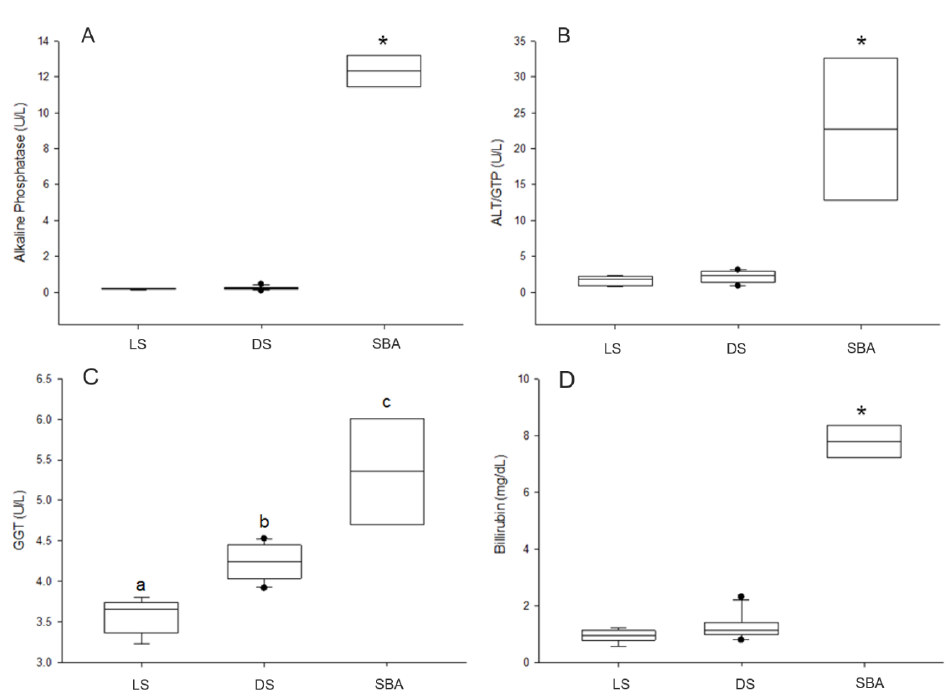
Figure 5. Hepatobiliary markers analyzed in tiger sharks. ( A ) Alkaline Phosphatase (ALP) activities, ( B ) Alanine Transaminase (ALT) activities, ( C ) Gamma-Glutamyl Transferase (GGT) activities, ( D ) Bilirubin concentrations. LS—live sharks, DS—dead sharks, SBA—sharks with bile accumulation. Boxplots respectively represent minimum, first quarter, median, third quarter, and maximum values. Post-hoc groupings are represented by lower case letters and (*).